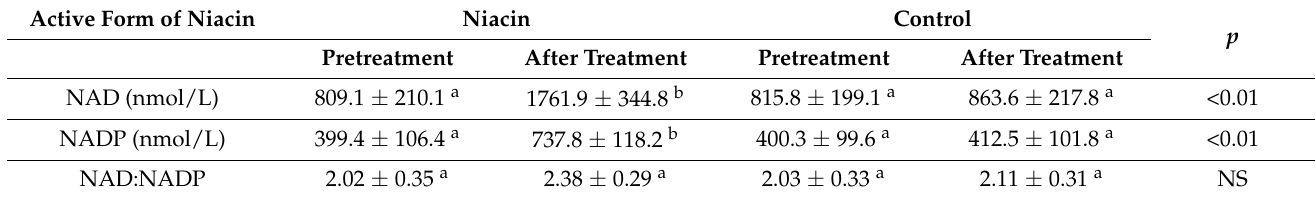
Table 1. Influence of niacin application on NAD, NADP and the NAD:NADP ratio. Abbreviations: Nicotinamide adenine dinucleotide (NAD), nicotinamide adenine dinucleotide phosphate (NADP), ratio (NAD:NADP).